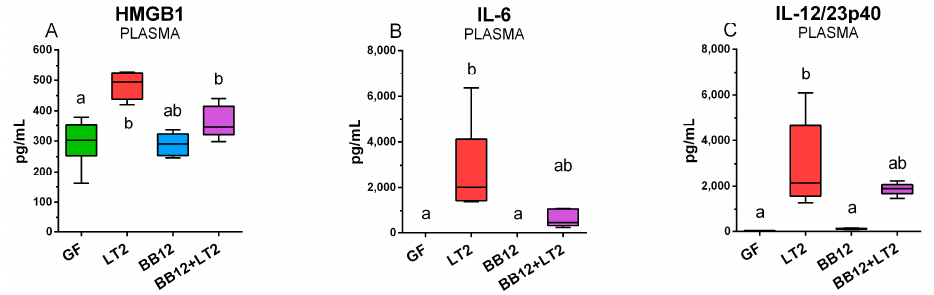
Figure 8. Plasma concentrations of HMGB1 ( A ), IL-6 ( B ) and IL-12/23p40 ( C ) proteins of one-week-old piglets: germ-free (GF), infected with S . Typhimurium LT2 for 24 h (LT2), associated with B. animalis subsp. lactis BB12 (BB12), and associated with BB12 and infected with LT2 for 24 h (BB12 + LT2). Six samples in each group were analyzed and statistical differences were calculated by the Kruskal–Wallis test with Dunn’s multiple comparison post hoc test. The values are presented as boxes and whiskers indicating the lower and upper quartiles, the central line is the median, and the ends of the whiskers depict the minimal and maximal values. A p < 0.05 among groups is denoted with different letters around the columns.